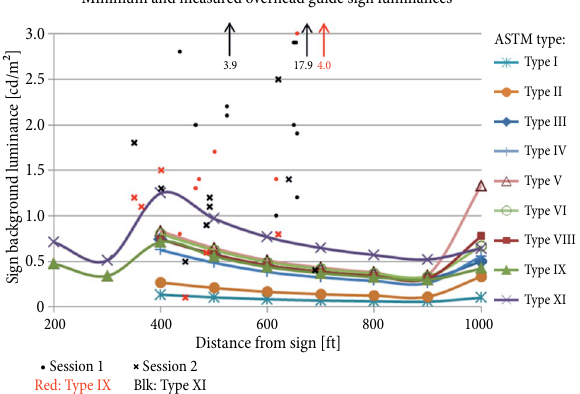
Fig. 4. Measured sign luminances for both measurement sessions, plotted as a function of the measurement distance. Also shown are the minimum luminances expected for each ASTM D4956-16 sign material type; different symbol shapes/ colors represent different sessions and sheeting materials